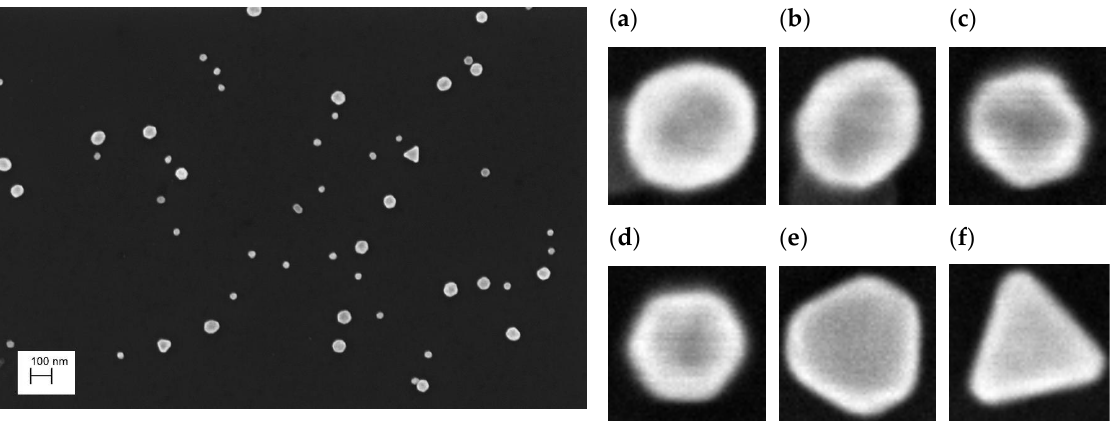
Figure 2. ( left ) Typical SEM image of the nPSize01 gold NPs and ( right ) various nanoparticle shapes ( a – f ) found in the sample: some examples are given of near-spherical shapes ( a , b ), icosahedral and decahedral shapes ( c , d ) and truncated tetrahedral shape ( e , f ).